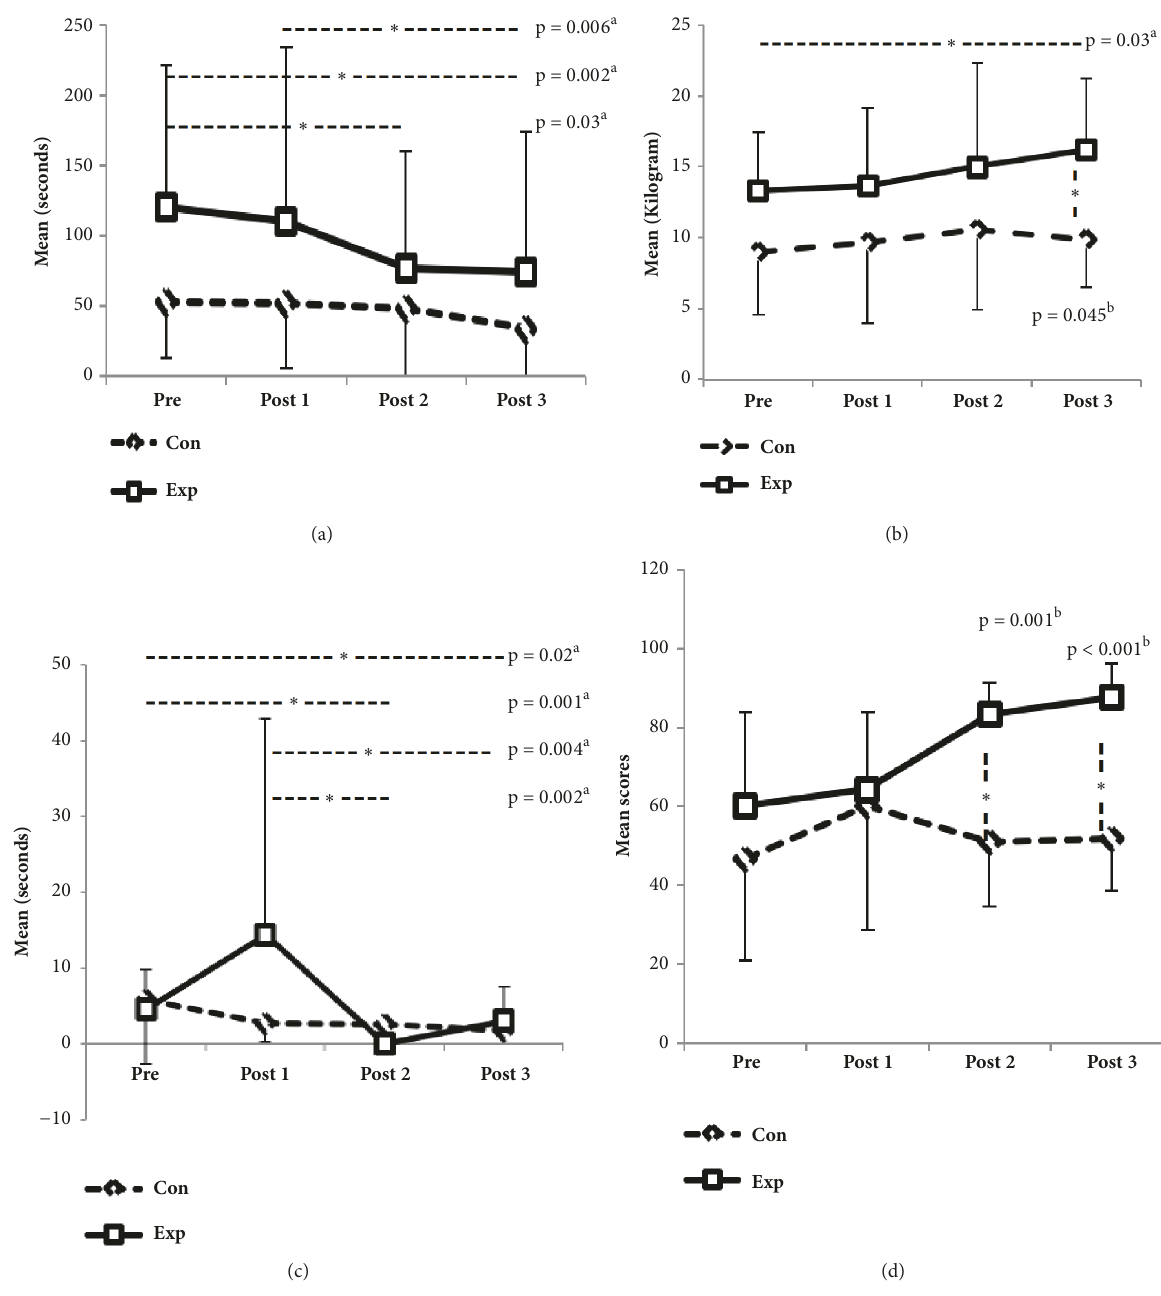
Figure 3: Graphs showing group-by-time interaction with pairwise comparisons for (a) Wolf motor function test-total movement time, (b) grip strength, (c) pencil lifting item, (d) stroke impact scale-global recovery; Con: control group, Exp: experimental group, ∗ : significant difference at p < 0.05, a: significant across the tests in the experimental group, b: significant between the groups. The data transformation has addressed the issue regarding the standard deviation that was larger than mean 14.44 (28.48) at post 1 for pencil lifting